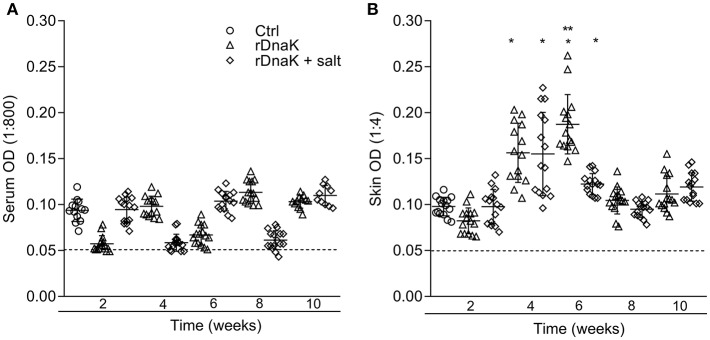
Evaluation of antibodies generated against F. columnare recombinant DnaK protein. The different groups are labeled as indicated in the figure. (A) The serum IgM antibody titer (1:800) is the reciprocal of the maximum dilution at which we could reliably detect binding of antibody to F. columnare rDnaK. (B) The skin IgM antibody titer (1:4) is the reciprocal of the maximum dilution at which we could reliably detect binding of antibody to F. columnare rDnaK. The mean absorbance ± SD for each group is shown as a horizontal line. Asterisk(s) denote a significant difference, P < 0.05. (*), indicates a significant difference when compared to the non-immunized control; (**), indicates a significant difference between immunized groups. The dashed line represents the mean background absorbance value observed using an isotype control.